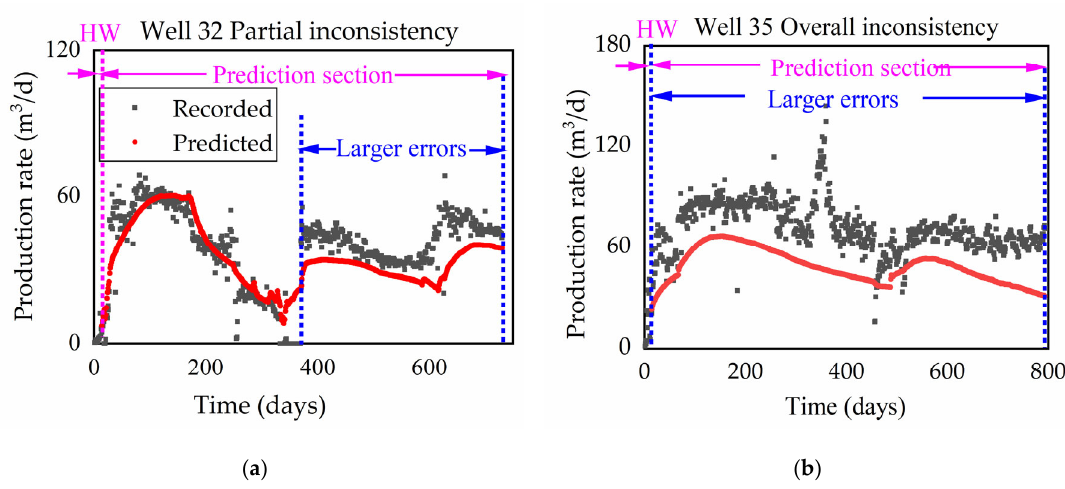
Figure 15. Typical prediction results of training wells with big relative errors: ( a ) partial inconsistency; ( b ) overall inconsistency.